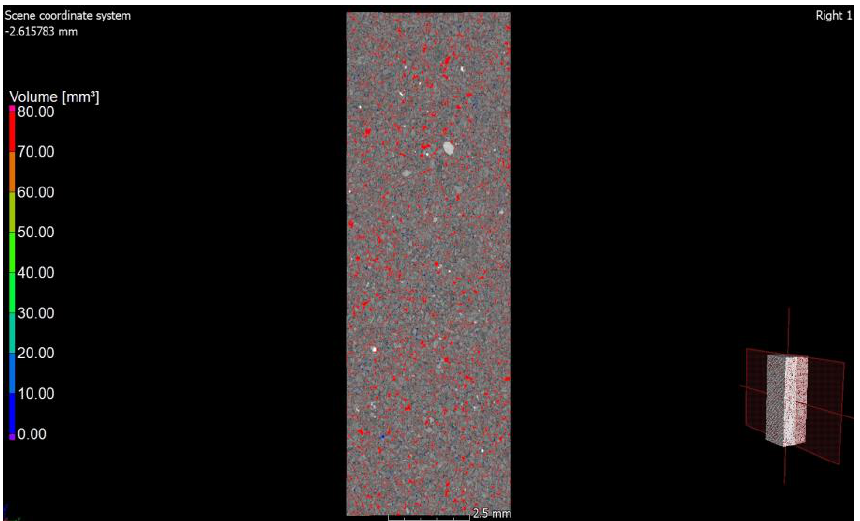
Figure 11. Cross-section through a sample of silicate material modified with glass sand. The drawings show a high number of small air voids.